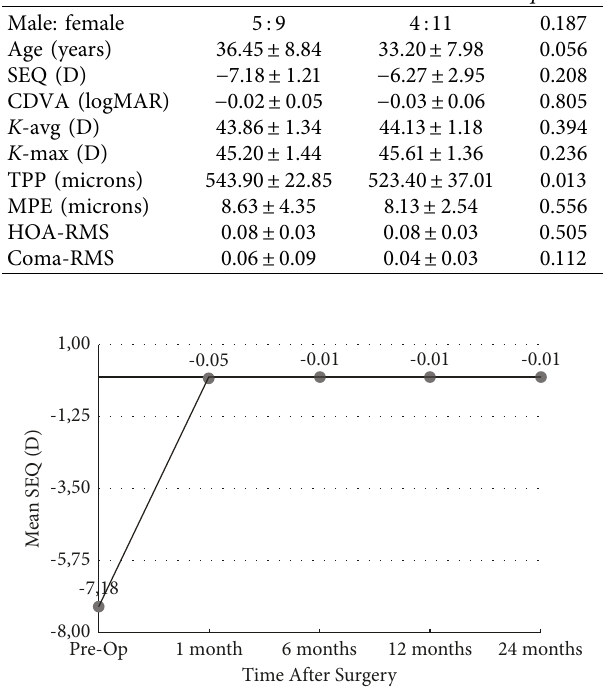
Figure 1: Stability of manifest refraction spherical equivalent over time in the SMILE group ( y -axis: spherical equivalent in diopters; x -axis: postoperative time interval in months).